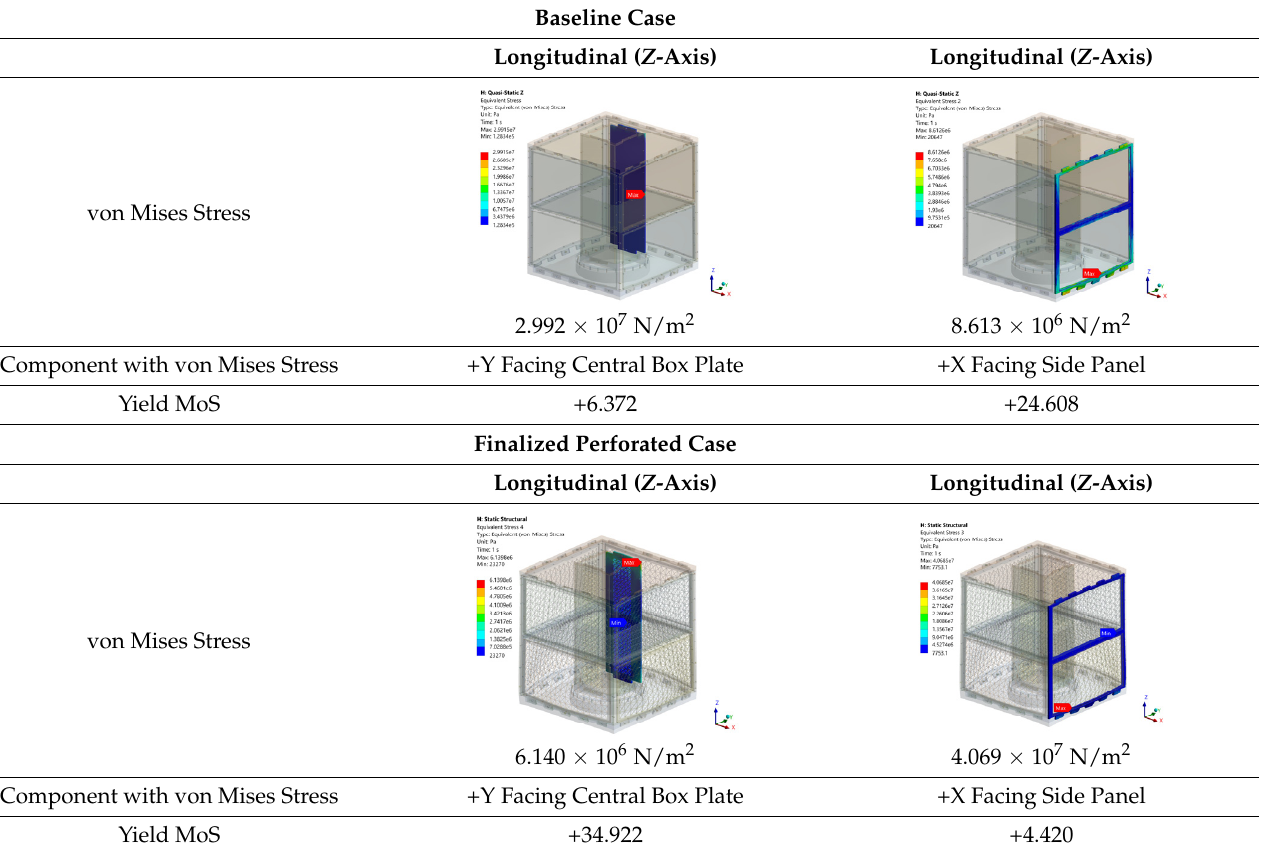
Table 5. Baseline and perforated quasi-static launch loads—von Mises stresses, longitudinal direction.